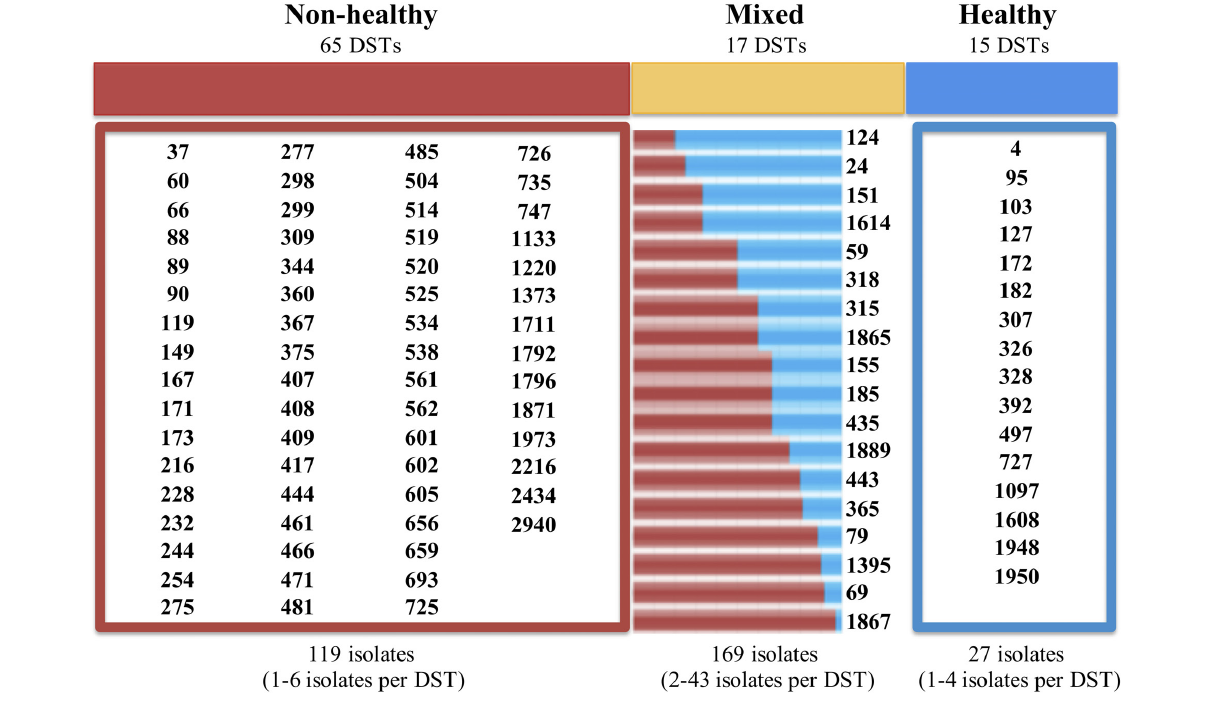
FIGURE 1 | Distribution of DSTs according to their potential impact on the hosts. “Non-Healthy” correspond to the DSTs identified in the isolates obtained from individuals with some pathology. “Healthy” are defined as DSTs reported from the isolates obtained from healthy individuals. The “Mixed” category included the isolations obtained from individuals with pathologies, as well as from healthy. The numbers at the bottom of each panel describe the total number of DSTs reported in each category, and the frequency range for the reported DSTs is shown in parentheses. In the case of “Mixed” DSTs, the bars represent the frequency of Non-Healthy (in red) and commensal (blue) isolates reported for each